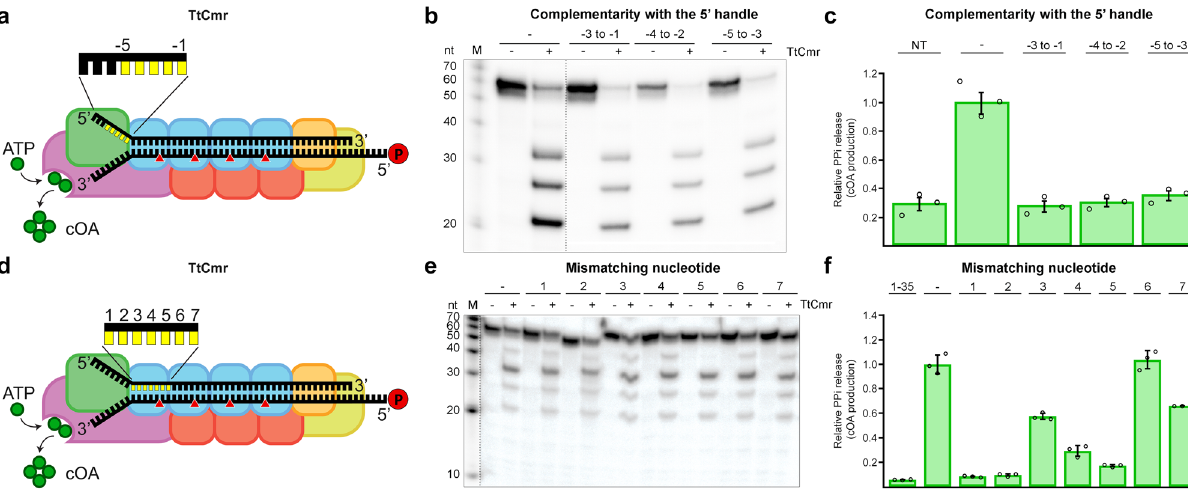
Fig. 2 Impact of complementarity in the 5 ′ handle and mismatches in the fi rst spacer region on RNA targeting and cOA production. a Schematic illustration of the TtCmr complex bound to a target RNA (4.5 target RNA, Supplementary Table S1), showing the different subunits in different colors, crRNA (top strand) and target RNA (bottom strand). The target RNA was labeled at the 5 ′ end with 32 P ( “ P ” in the red circle). Red triangles indicate the cleavage sites within TtCmr. Highlighted in yellow are the fi rst 5 nucleotides in the 5 ′ handle of the crRNA (nucleotides − 1 to − 5). b Different target RNAs (Supplementary Table S1) with matches to the 5 ′ handle were used in an activity assay and analyzed on denaturing PAGE. c Impact of 5 ′ handle complementarity on PPi release as a measure of COA production. d Similar schematic illustration as panel a with the fi rst 7 nucleotides of the spacer region of the crRNA highlighted in yellow. e Similar activity assay as in panel b but with RNA targets (Supplementary Table S1) with single mismatches in the fi rst 7 nucleotides of the spacer region of the crRNA. f Impact of mismatches in the target RNA with the fi rst 7 nucleotides of the spacer region of the crRNA on PPi release, as a measure for COA production. Discontinuous gel lanes are indicated by a dashed line. The results of the cleavage assays and cOA production assays displayed in this fi gure are representative results of three replicates (Supplementary Fig. S6). Error bars represent the standard deviation of the mean. Source data are provided as a Source data fi